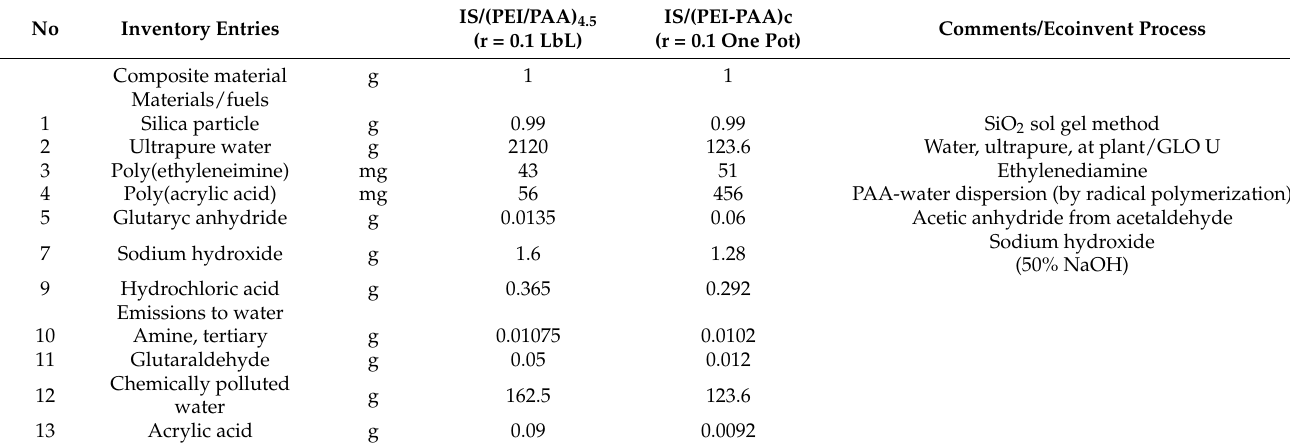
Table 2. Inventory data per 1 g of silica//PEI